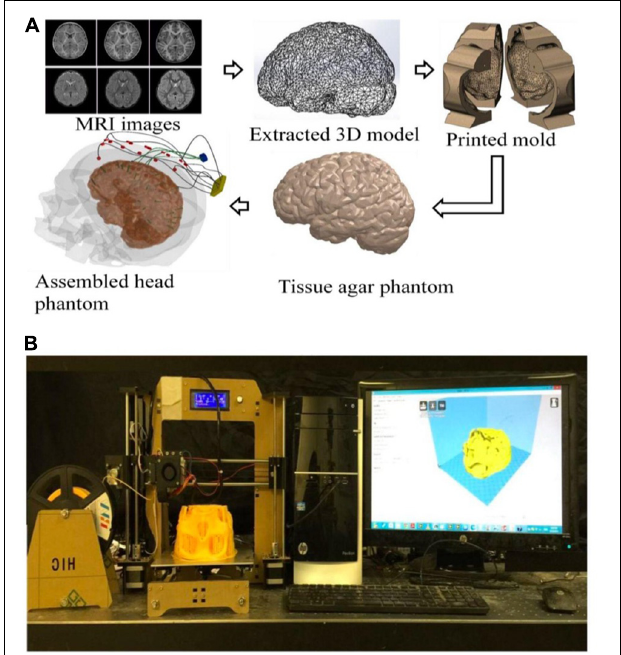
FIGURE 1 | (A) An illustration of the process flow to fabricate a high-fidelity head phantom for tDCS model validation; (B) a picture of the 3D filament-based 3D printer for tissue mold